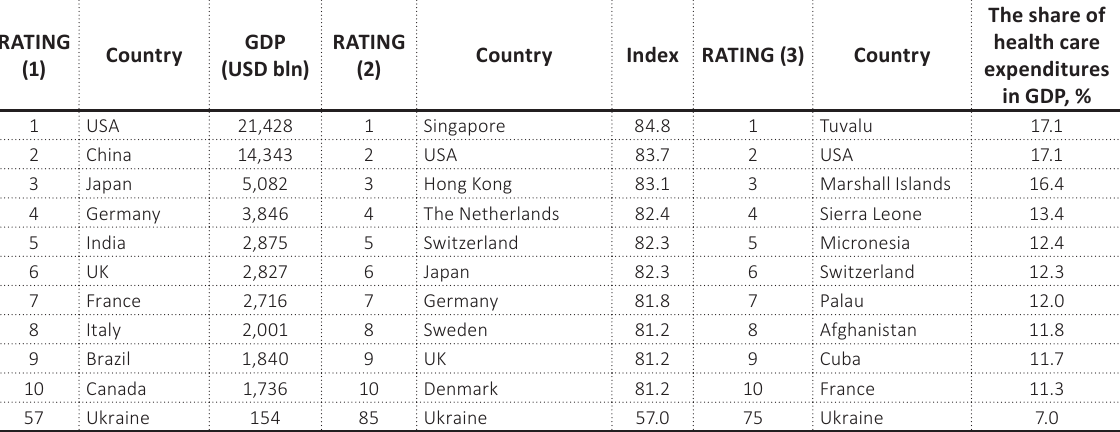
Table 3. The World Bank